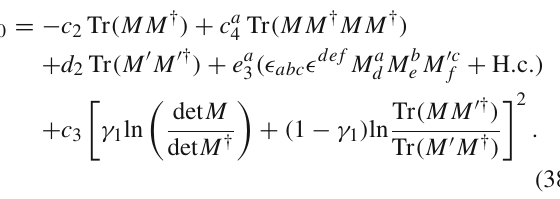
[156] with low-energy constants taken from [157] and [158] respec- tively (sixth and seventh rows); estimates of Ref. [150] using Belle data (eighth and ninth rows); and two-channel unitarity model of [151] (last two rows) a 1 b 1 0 0